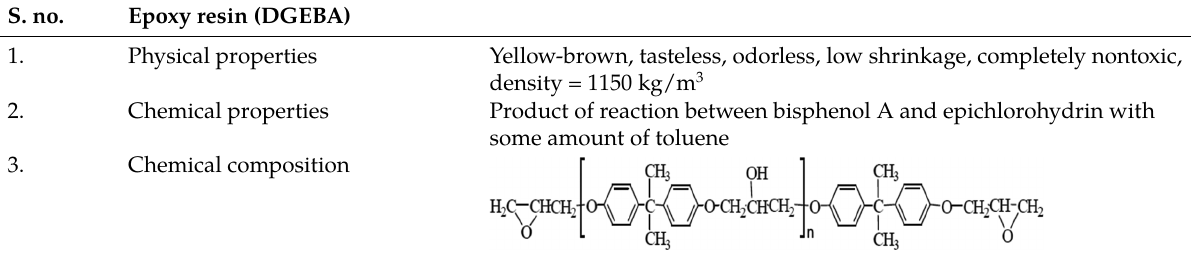
Table 1: Physical and chemical properties of epoxy resin. S.